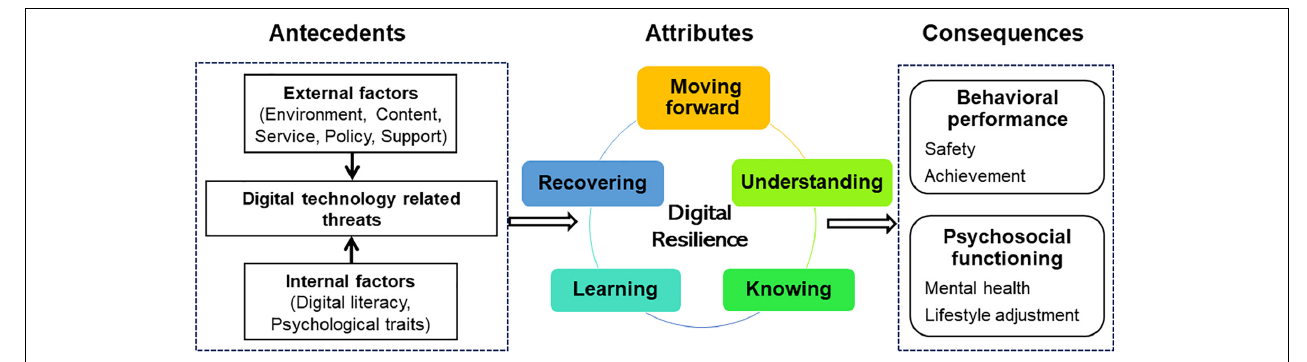
FIGURE 2 | Preliminary conceptual model of digital